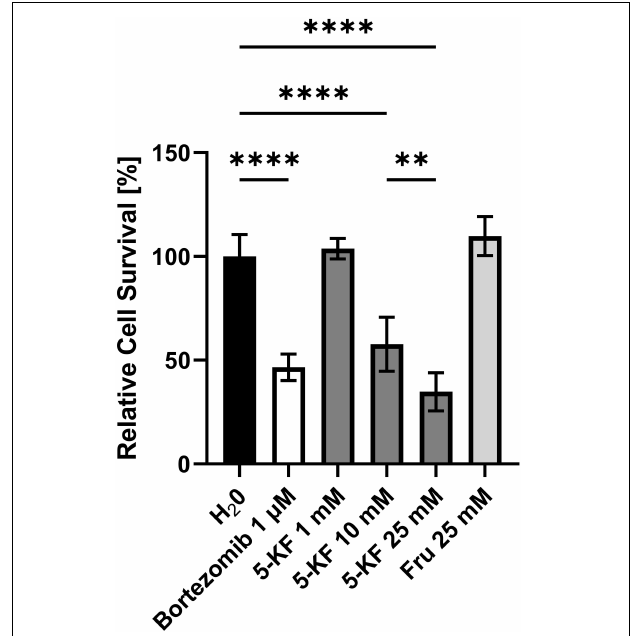
FIGURE 4 | Relative cell survival of HT-29 cells subjected to the MTT assay. The relative cell survival displayed is based on the absorbance caused by formazan crystals produced by HT-29 cells during the MTT assay. HT-29 cells (10,000 cells per well) were incubated in DMEM high glucose medium supplemented with 10% fetal bovine serum (FBS) and antibiotic–antimycotic at 37 ◦ C in a humidified 5% CO 2 atmosphere. Cells were supplemented either with H 2 O pure or various concentrations of bortezomib, 5-KF, or D -fructose. Once sufficient confluence was reached, the medium was removed from the 96-well plate and MTT was added to each well. The absorbance in each well, caused by redissolved formazan crystals, was measured at 570 nm using a Tecan Infinite 200 M Plex plate reader (Tecan Gr oup AG). Tukey’s multiple comparison test was performed using GraphPad 9.3.1 (GraphPad Software, San Diego, US) to determine statistical significance; ∗∗∗∗ p < 0.0001; ∗∗ p = 0.023. The experiment was performed using six biological replicates for each test